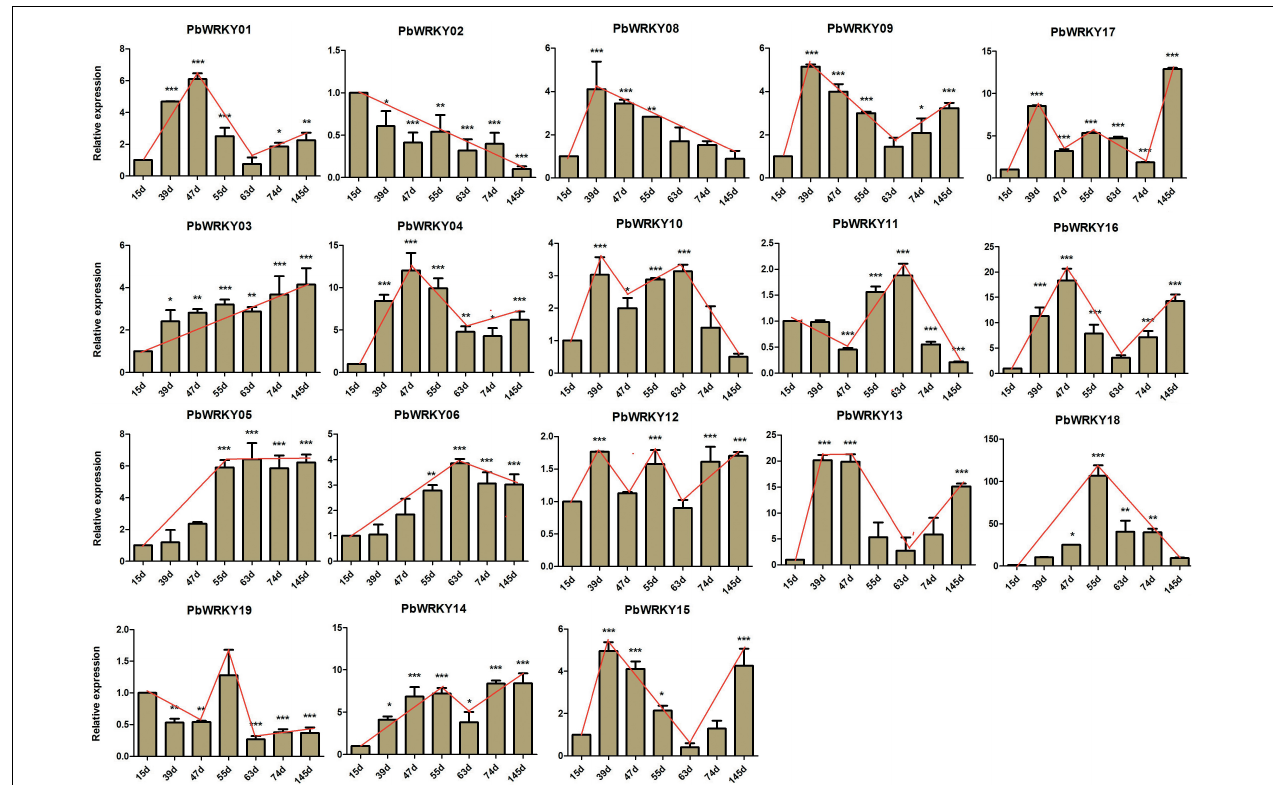
FIGURE 7 | Expression patterns of PbWRKY genes during eight developmental stages of P. bretschneideri fruit at 15, 39, 47, 55, 63, 79, and 145 days after flowering (DAF). *Significant difference compared with the expression level at 15 DAF ( p < 0.05). TABLE 2 | The divergence between duplication PbWRKY gene pairs in P. bretschneideri .